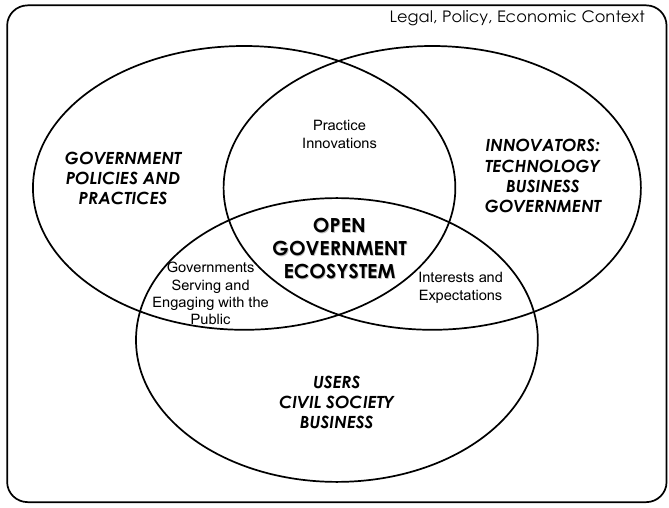
Figure 1. Domains and environment comprising an open government